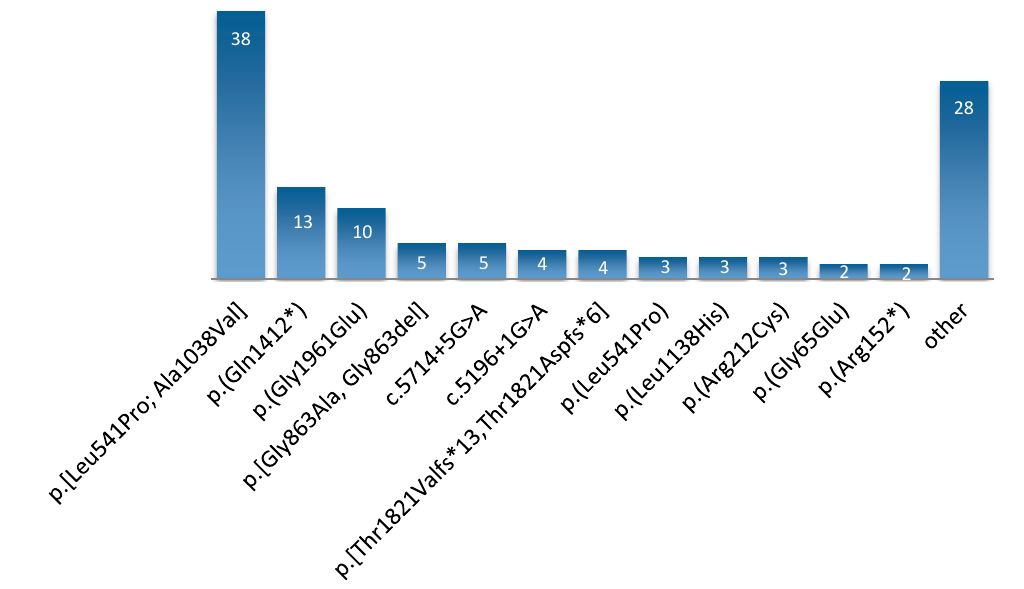
Figure 2. Number of alleles for the most common variants. The most prevalent, complex allele was found on 38 chromosomes. Its component, c.1622T > C, p.(Leu541Pro), was identified independently on three additional alleles. Unique causative alterations present on one chromosome in a single patient are combined within “other”.